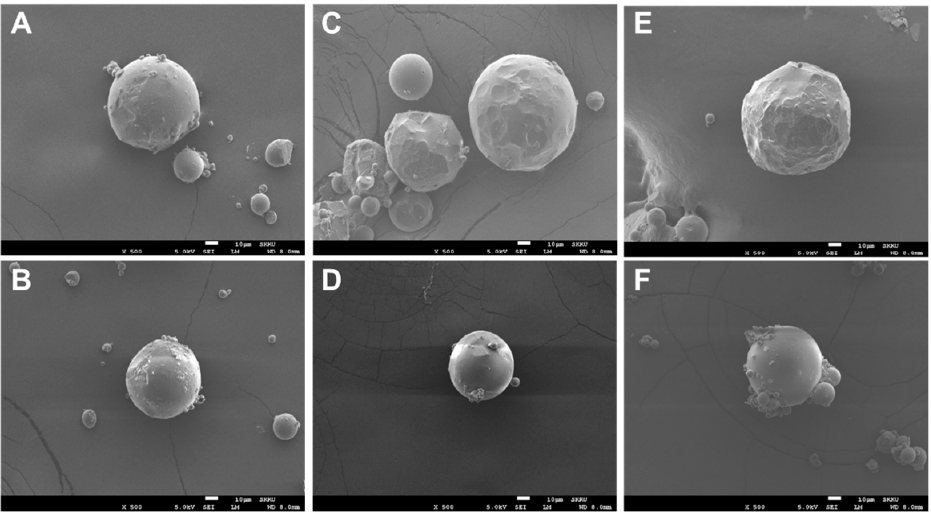
Figure 1. SEM images of rivoceranib microspheres. ( A , B ) microspheres were fabricated using PLGA RG502, ( C , D ) microspheres were from PLGA RG502H, ( E , F ) microspheres were from PLGA RG503H. Microspheres ( A , C , E ) were prepared at the emulsifying speed of 1500 rpm. Microspheres ( B , D , F ) were prepared at 2000 rpm. Scale bars = 10 µm.